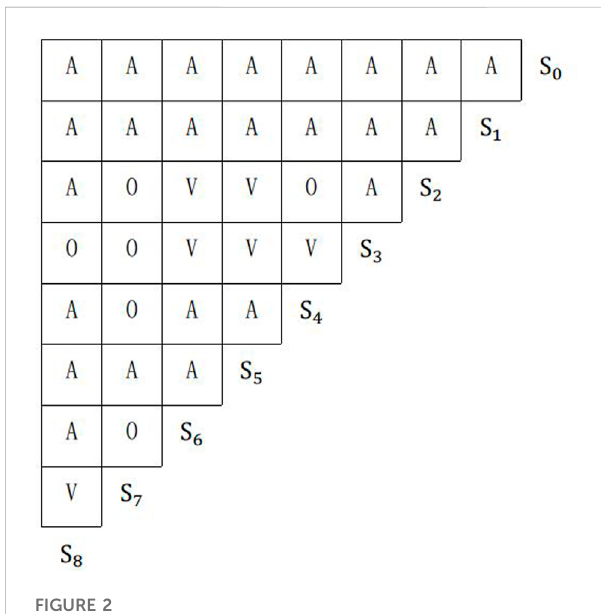
FIGURE 2 The logical relationship of the eight in fl uencing